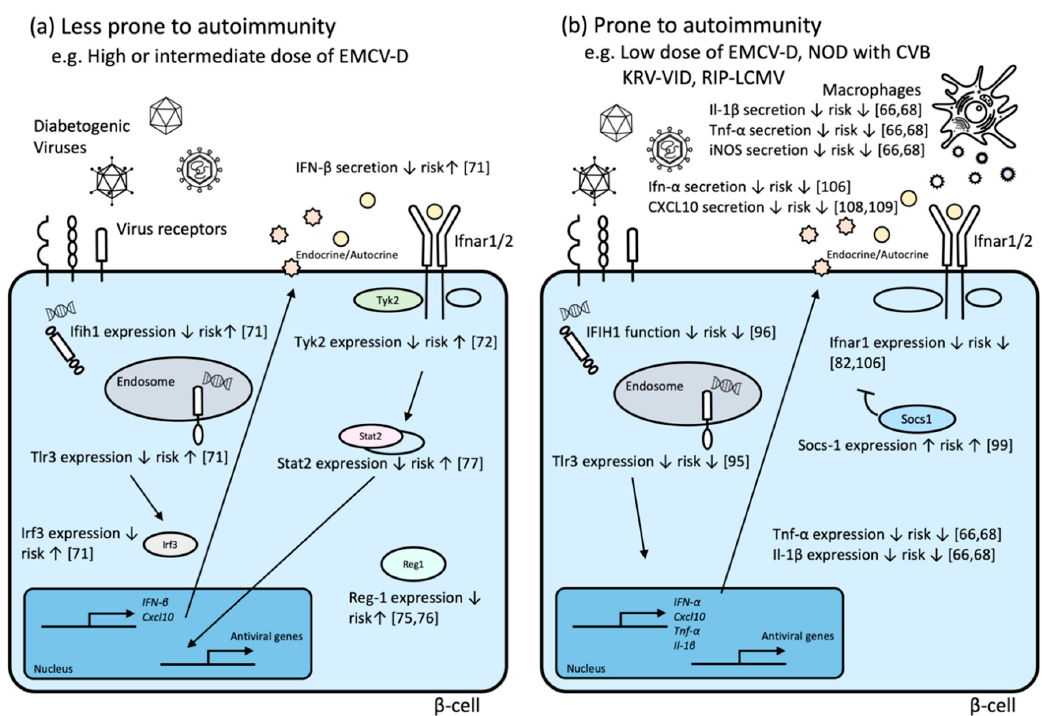
Figure 1. Virus-induced diabetes-associated genes in animal models reviewed in this article. ( a ) These candidate genes were reported from studies of hosts that are less prone to autoimmunity. ( b ) These candidate genes were reported from studies of hosts that are prone to autoimmunity. The numbers in square brackets are reference article numbers.